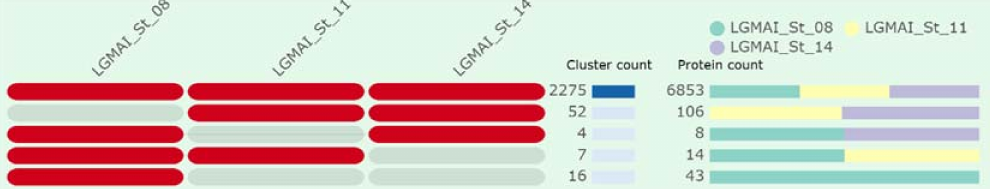
Figure 6. Cluster and protein counts identified by the genome comparison web server OrthoVenn2.